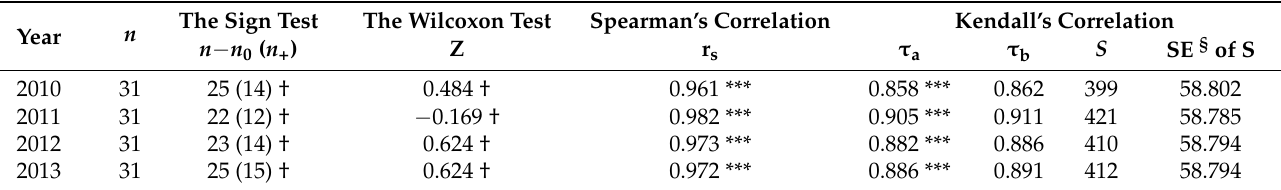
Table 6. Results of the sign test, the Wilcoxon test, and Spearman’s and Kendall’s correlation tests for HLE ranks for the total population and the older sub-population in